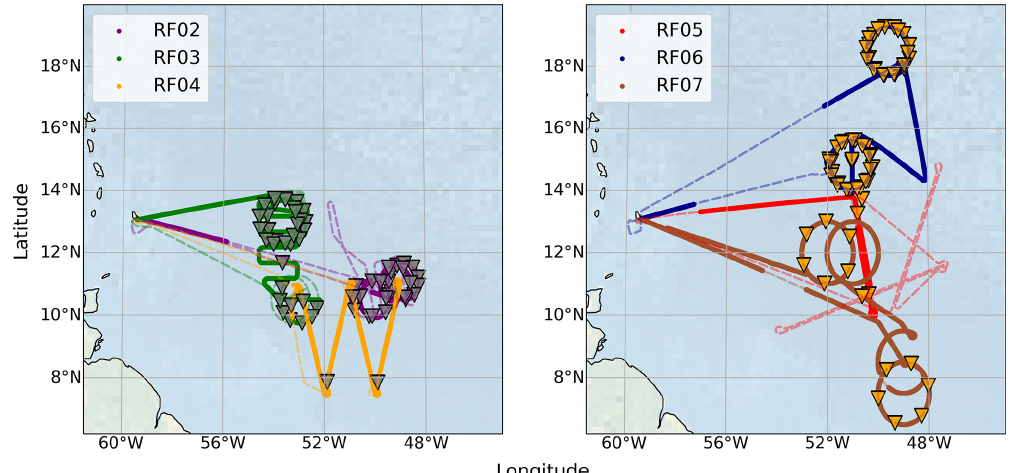
Figure 1. Considered flight tracks from NARVAL II (dashed lines) that provide observations of tropical clouds from the radar and imager specMACS. Periods in which both devices (radar and imager) were operating reliably and simultaneously are highlighted as bold lines. Dropsonde releases less than 15min away from overlapping measurements of radar and imager are indicated as triangles. Background map was made with Natural